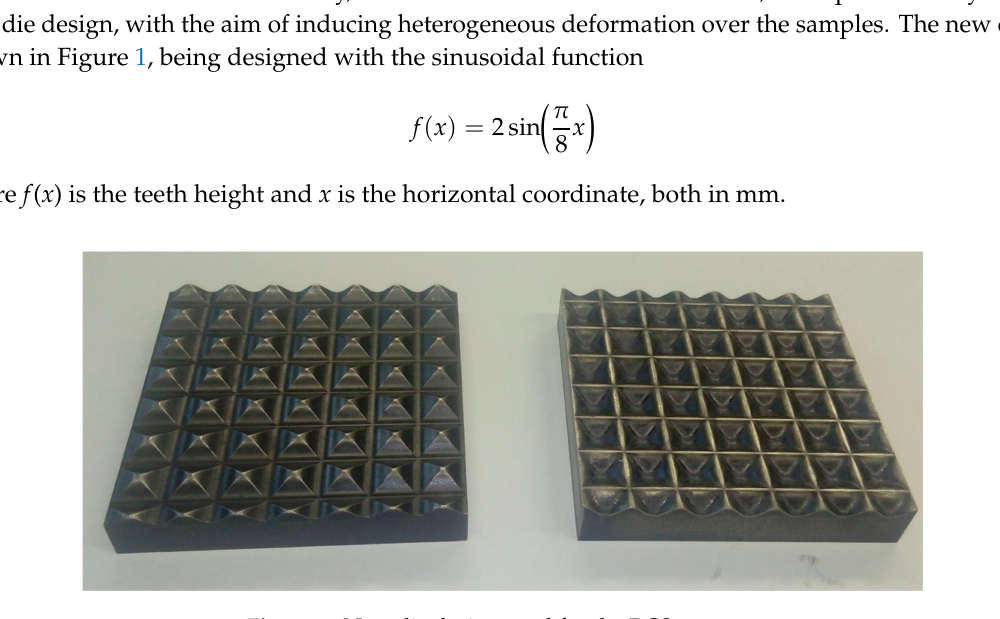
Figure 1. New die design used for the RCS